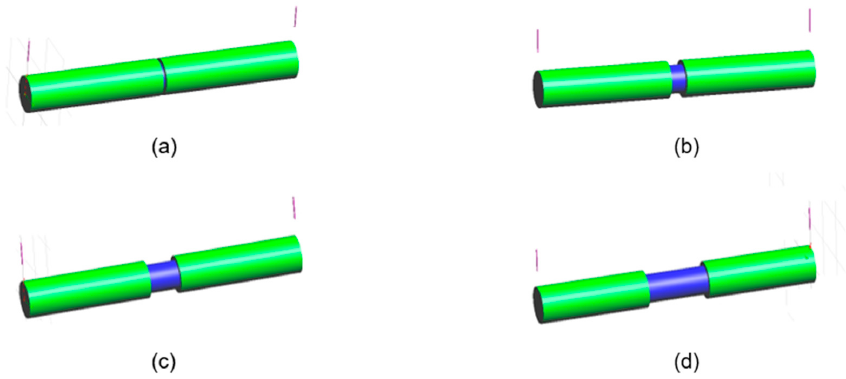
Figure 4. 3D modeling of pipeline according to the defect ratio: ( a ) 1%, ( b ) 5%, ( c ) 10%, ( d ) 20%. Table 5. Basic design parameters related to the structural factors.